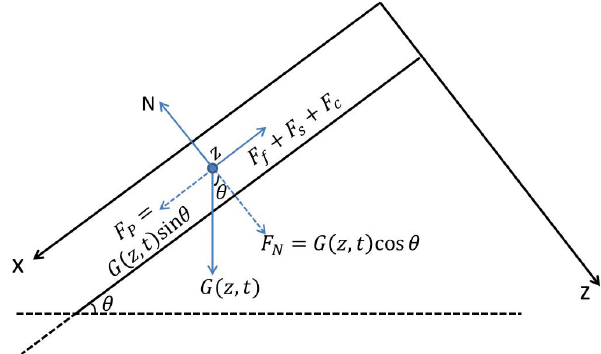
Fig. 2. Slope stability index classified by relationship between de- gree of soil saturation and slope, modified from Fig. 2 in Mont- gomery and Dietrich (1994).